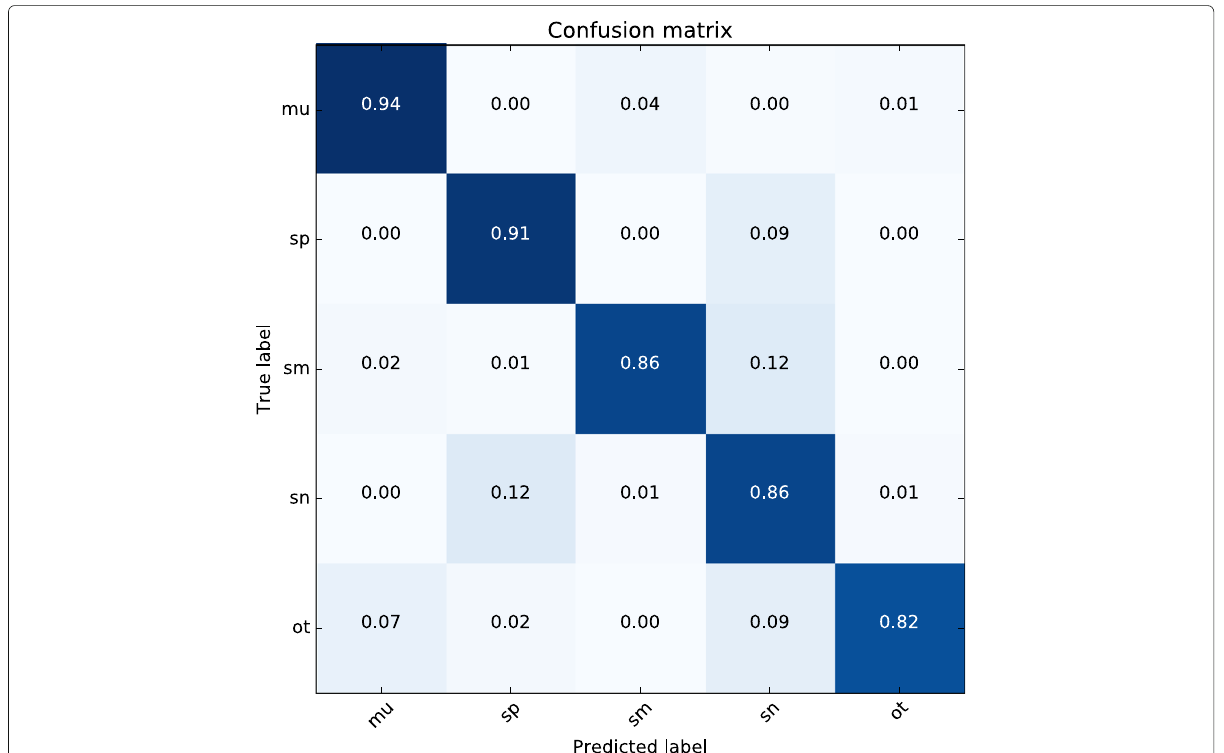
Fig. 8 Confusion matrix for the best parameter configuration evaluated in this paper: BLSTM 1 Pool BLSTM 2 RNN ( N = 10) trained with mixup ( α = 0.2) combined with the HMM